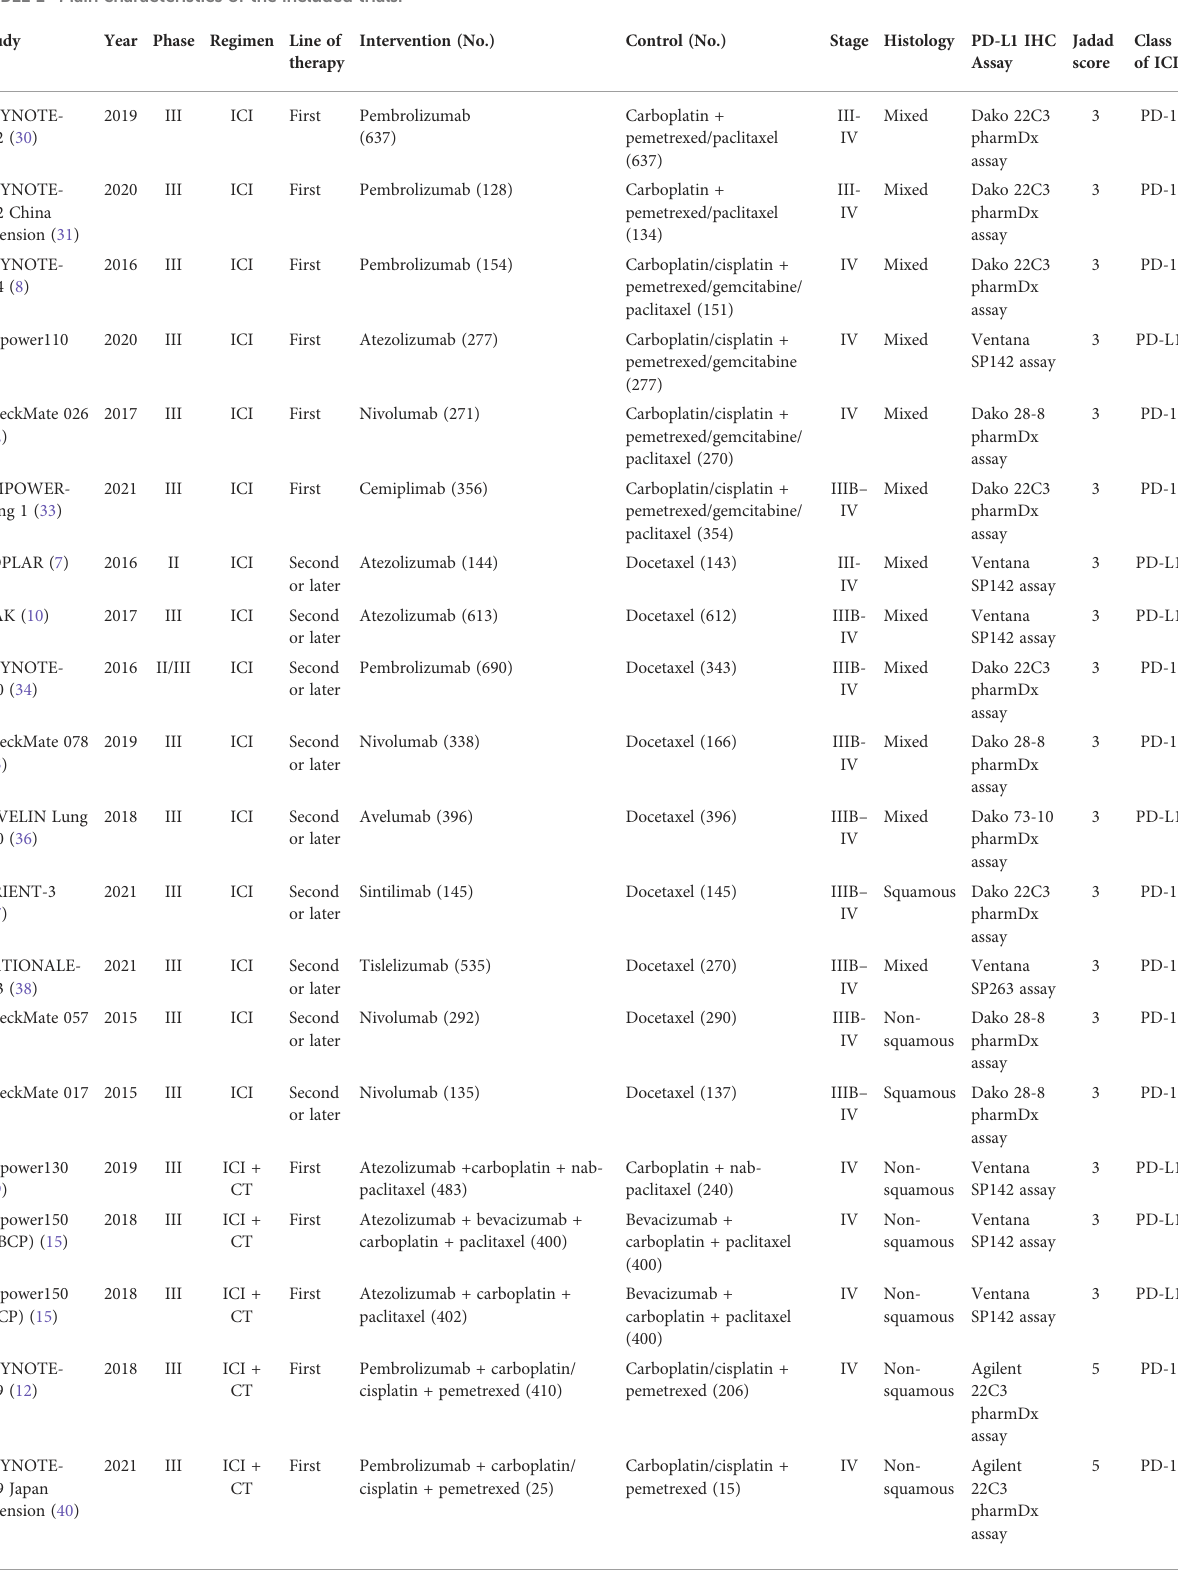
TABLE 1 Main characteristics of the included trials. Study Year Phase Regimen Line of